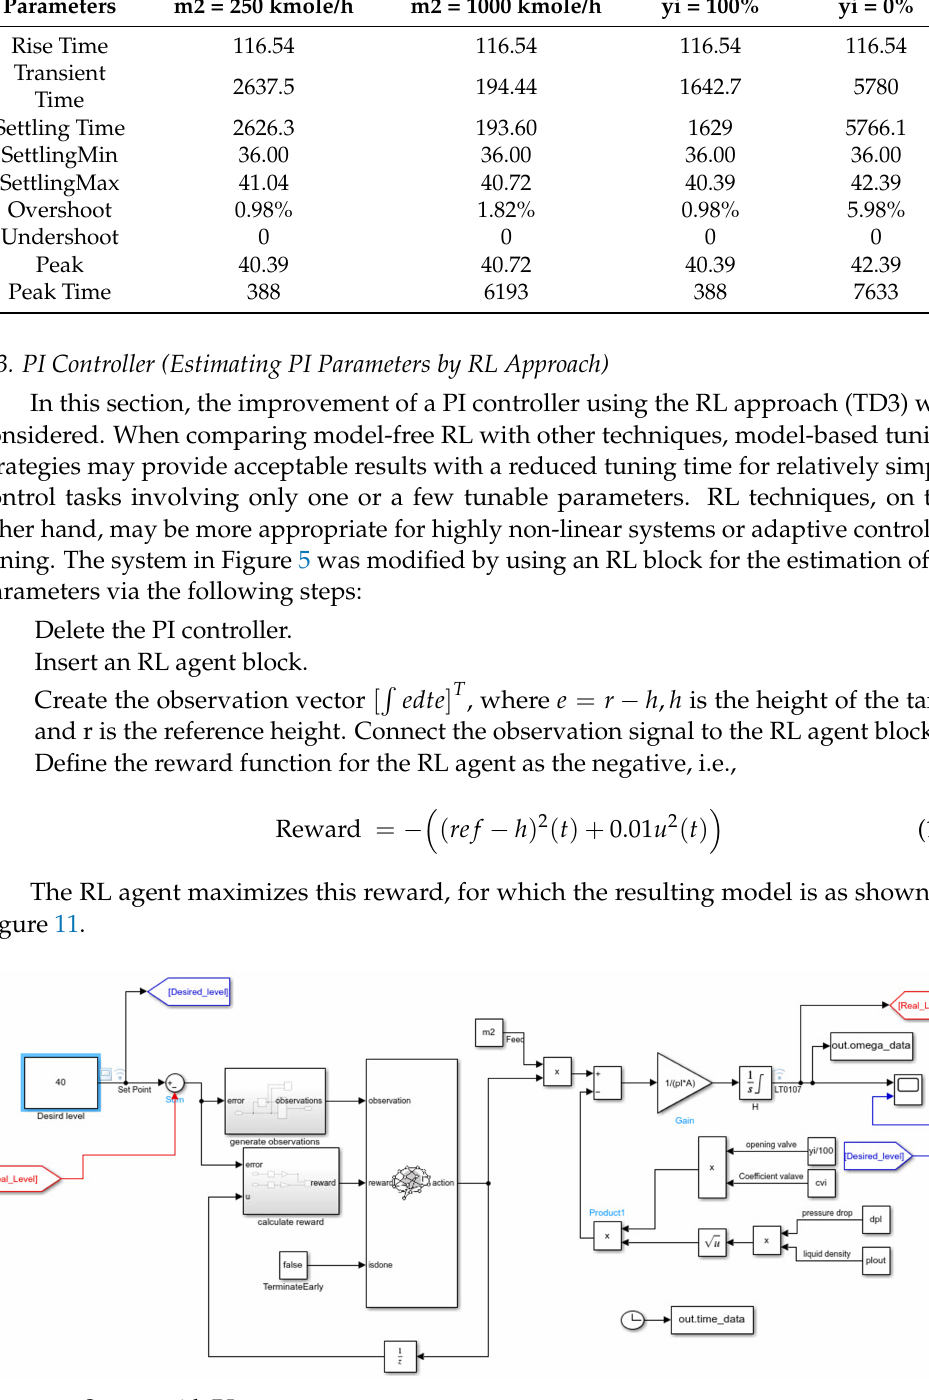
Figure 11. System with RL